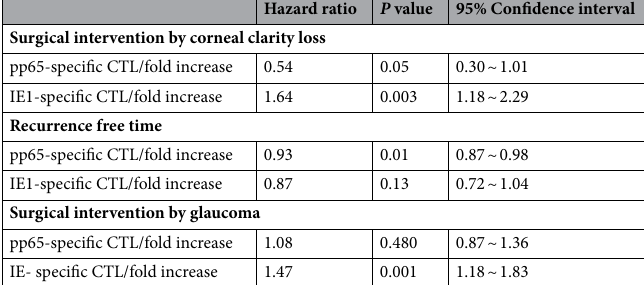
Table 4. Association of virus-specific CTL and prognosis using Cox proportional hazard